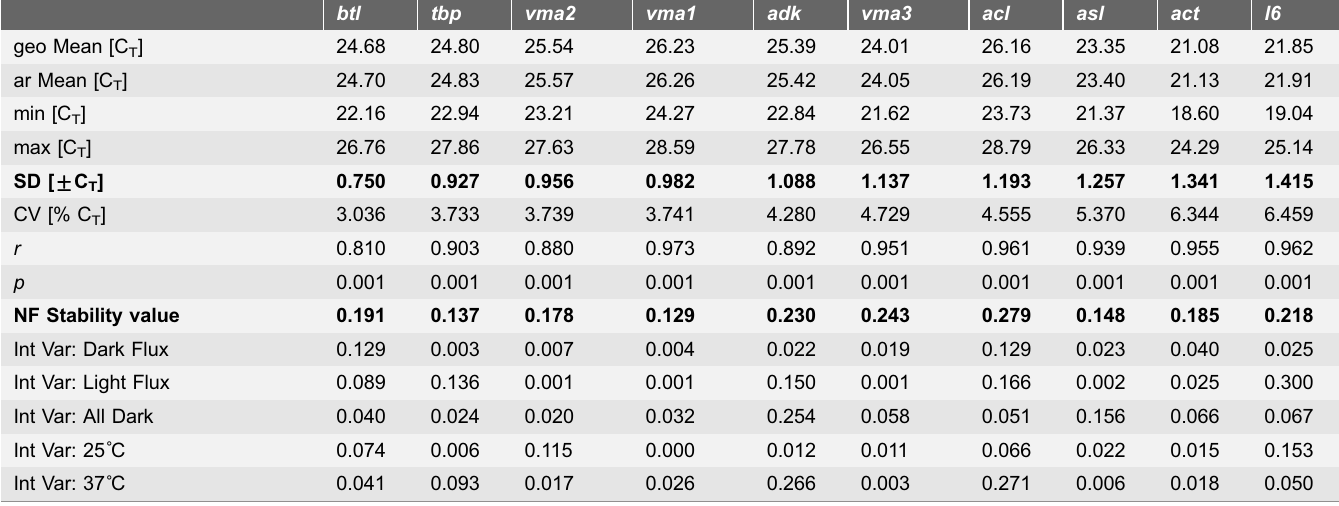
Table 5. Descriptive statistics and stability values of candidate reference genes under light/dark cycling, all-dark growth, and temperature fluctuations (n 5 30). btl tbp vma2 vma1 adk vma3 acl asl act l6 geo Mean [C T